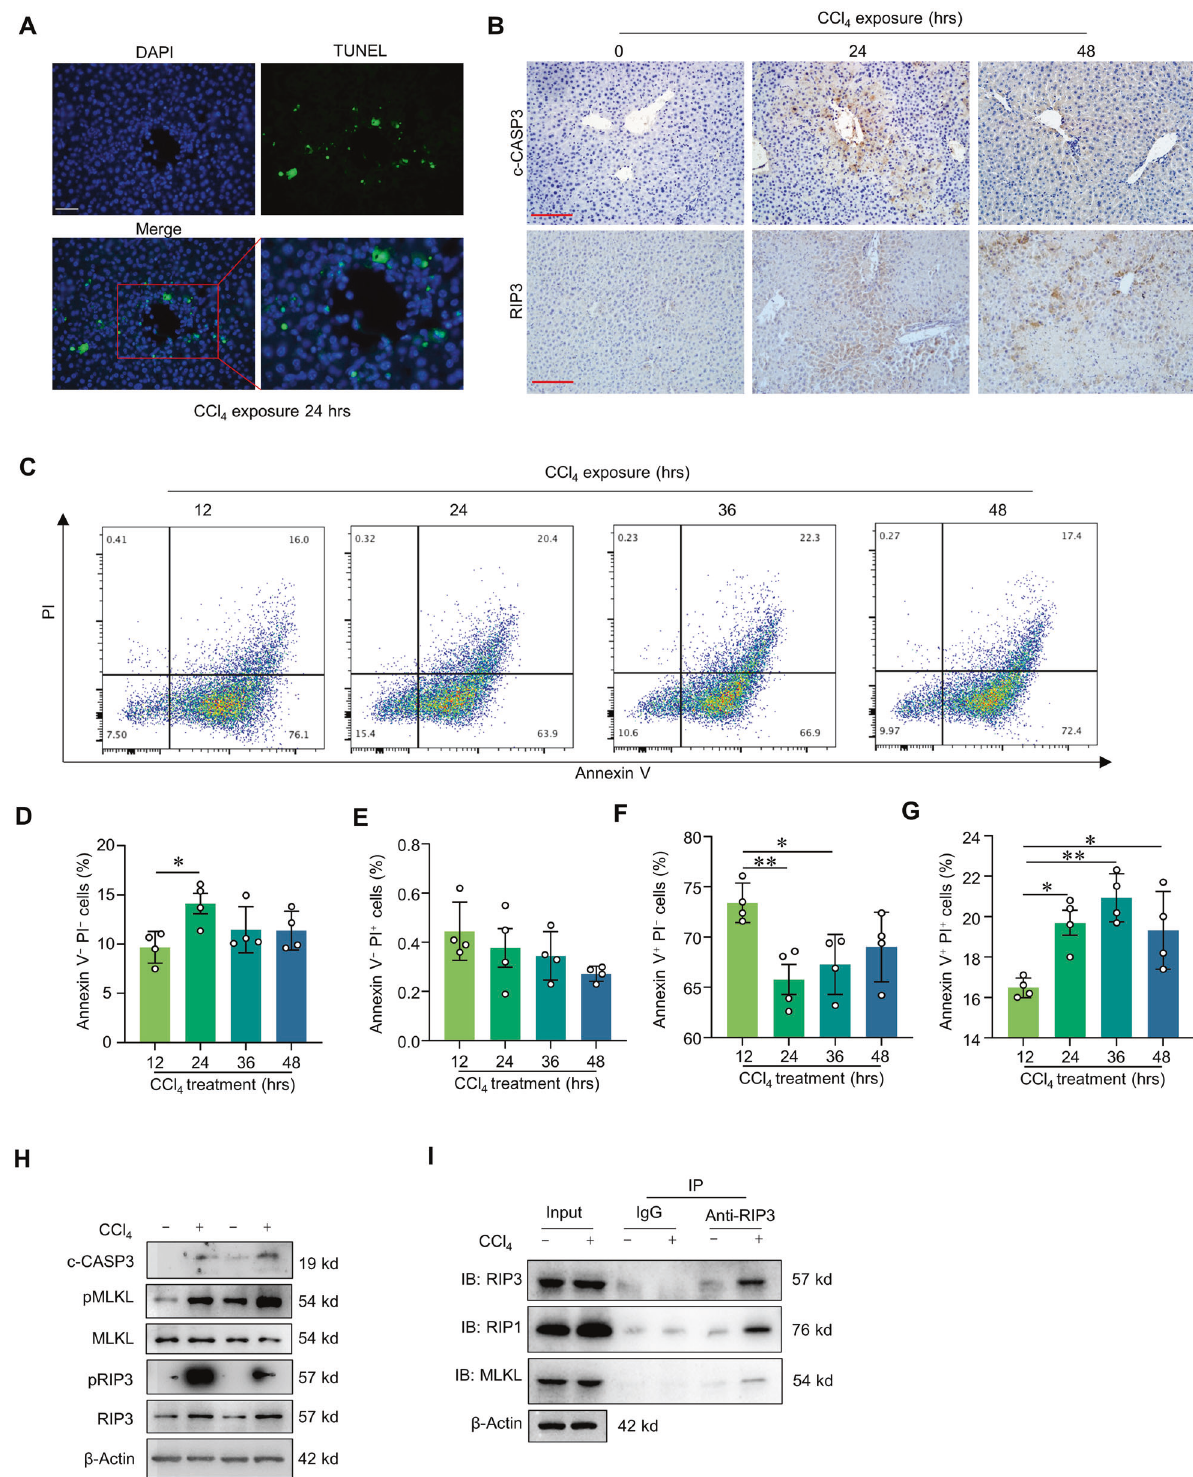
Fig. 1 Both apoptosis and necroptosis occurred in ALI mice liver induced by CCl 4 . Representative images of TUNEL assay ( A ) and liver cleaved caspase-3 (c-CASP3) and RIP3 immunohistochemical staining ( B ) in wild-type (WT) mice with CCl 4 induction. Scale bar: 100 μ m. C Representative images of fl ow cytometry analysis based on gating for Annexin V or PI signals to assess primary hepatocytes isolated from WT mice were treated with CCl 4 for 12, 24, 36 and 48 h. Ratio of Annexin V − PI − cells ( D ), PI + cells ( E ) Annexin V + cells ( F ) and Annexin V + PI + cells ( G ) in primary hepatocytes isolated from WT mice with CCl 4 treatment for 12, 24, 36, and 48 h ( n = 4). H Immunoblotting showed the liver Cleaved-Caspase-3 (c-CASP3), RIP3, pRIP3, pMLKL, and MLKL in WT mice with CCl 4 induction. I Co-immunoprecipitation was conducted to detect the interactions among RIP1, RIP3, and MLKL in primary hepatocytes with PBS, TS, TSZ, and CCl 4 treatment. ** p < 0.01, one-way ANOVA followed by Tukey ’ s multiple comparisons test ( D – G ). Data are represented as mean ± SD.